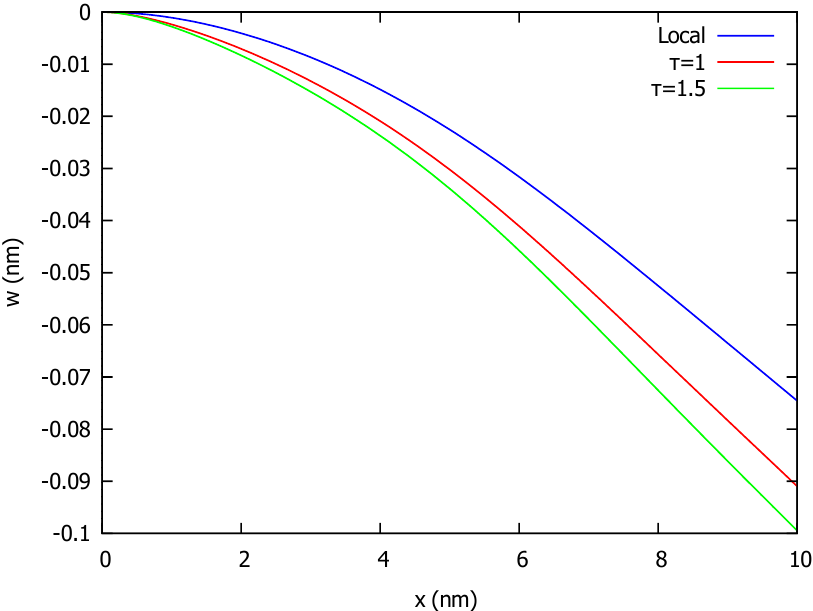
Figure 2. Deflection of cantilever beam (CF) under uniform load and several values of ξ 1 .